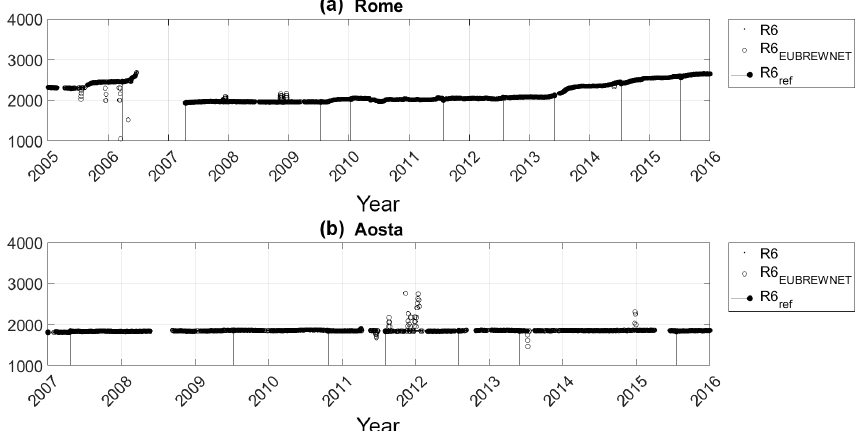
Figure 15. Daily averages of the ratios R 6 and R 6 EUBREWNET at Rome (a) and at Aosta (b) . Periods belonging to the three circumstances described in the Sect. 3.1 with the R 6 drift or spikes were removed. R 6 EUBREWNET values were downloaded by EUBREWNET. Vertical lines represent R 6 ref established during each calibration